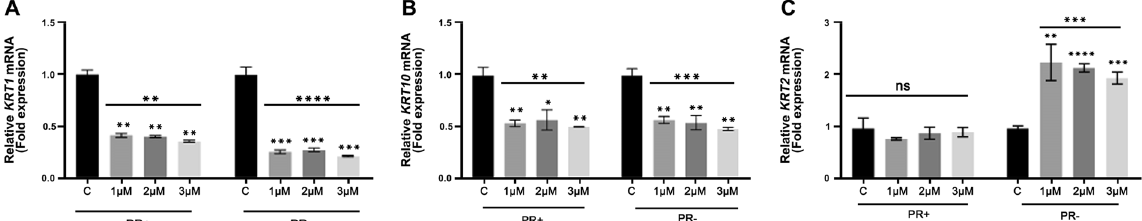
Figure 5. ATRA supresses KRT1 and KRT10 expression while KRT2 expression is increased. NHEK (200,000 cells) were mixed with 10 6 irradiated 3T3 fibroblasts in 2 ml of CS-FCS containing RM + with or without PR per well of a 12 well plate in triplicates for each ATRA concentration for 3 days. ATRA stock was made in DMSO and further diluted in ethanol (EtOH). The cells were grown in three different ATRA concentrations of 1 µ M, 2 µ M and 3 µ M and DMSO/EtOH was used as a vehicle control (0.003%/0.03% maximum) for 24 h after which the feeder was removed by squirting with PBS/EDTA and lysates were collected for qPCR analysis for ( A ) KRT1 , ( B ) KRT10 and ( C ) KRT2 . Data are shown as fold expression normalised to the expression of two housekeeping genes, POLR2A and YAP1 . Statistical analyses: n = 3, Error bars = SEM. One-way ANOVA (shown by a horizontal line over each graph) to measure the p values at different concentrations of ATRA compared to the control (no ATRA). Two-way ANOVA was used to measure the statistical significance between PR + and PR - groups for each keratin mRNA ( KRT1, KRT10, and KRT2 ), p values are given by asterisks (ns = p > 0.05,